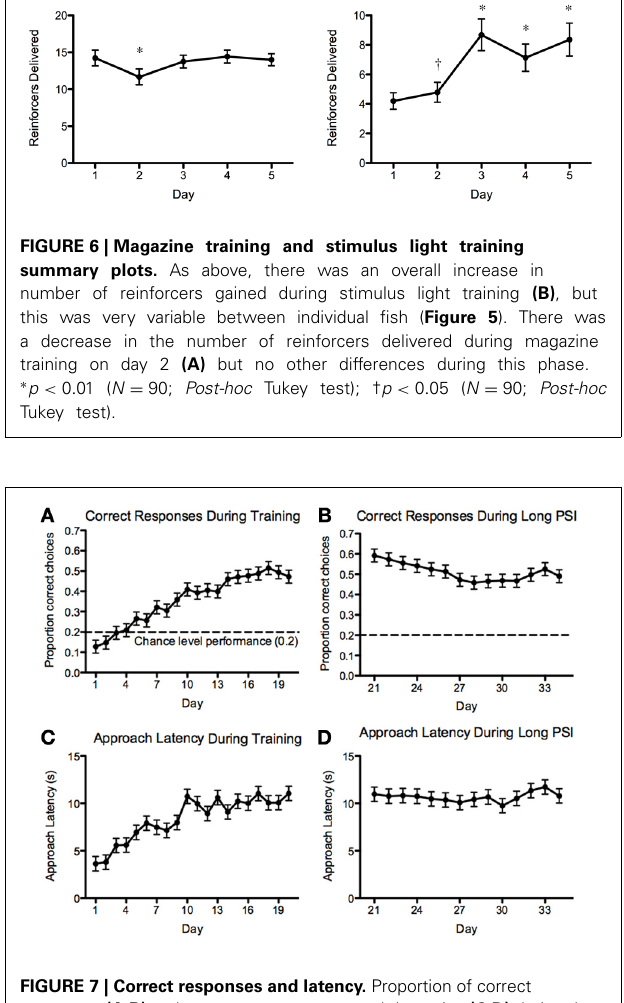
FIGURE 7 | Correct responses and latency. Proportion of correct responses (A,B) and correct-response approach latencies (C,D) during the 5 (A,C) - and 10 (B,D) -second PSI phases of training on the 5-CSRTT for all fish tested. Note: N = 60